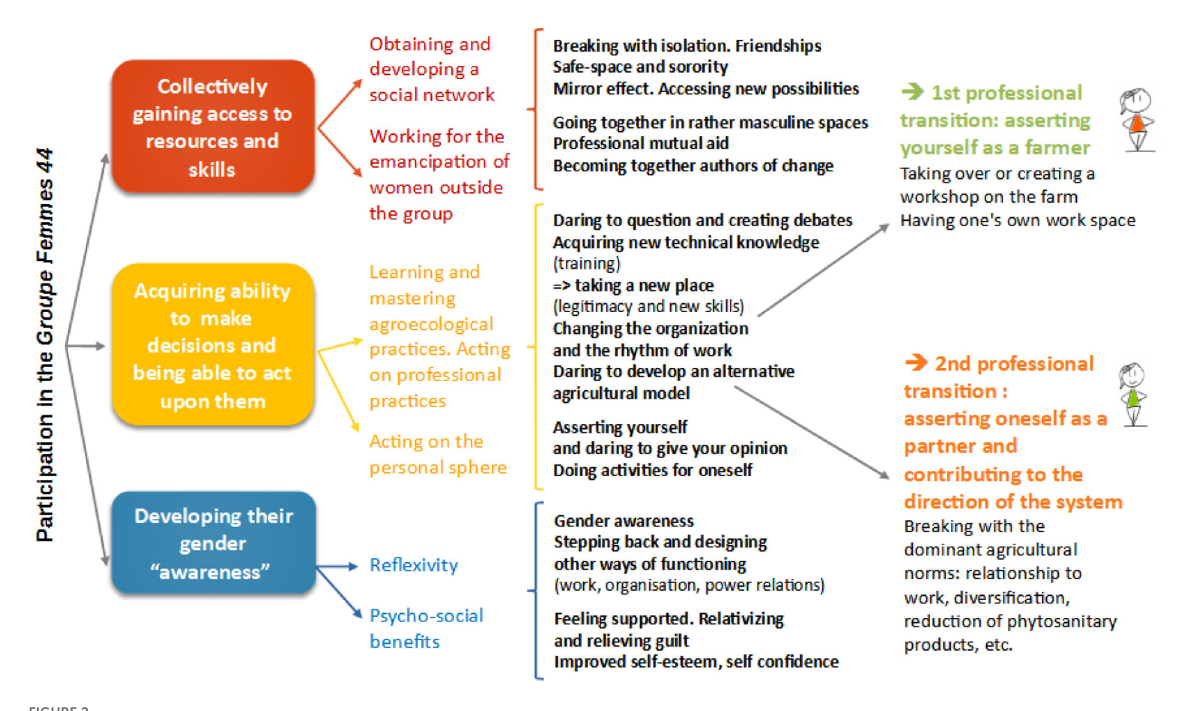
FIGURE2 The benefits of participation in Groupe Femmes 44